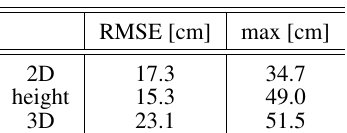
Table 2. Comparison between UWB and vision-based